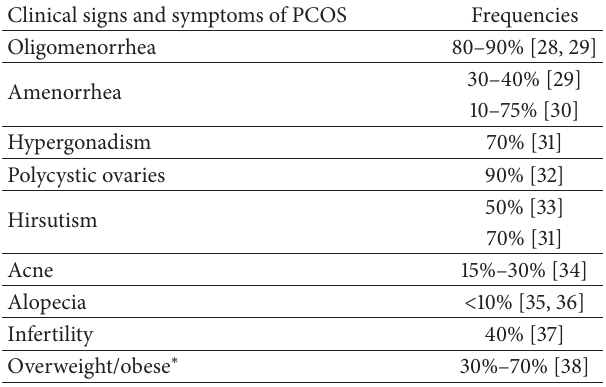
Table 2: Clinical phenotypes represented by consensus guidelines for